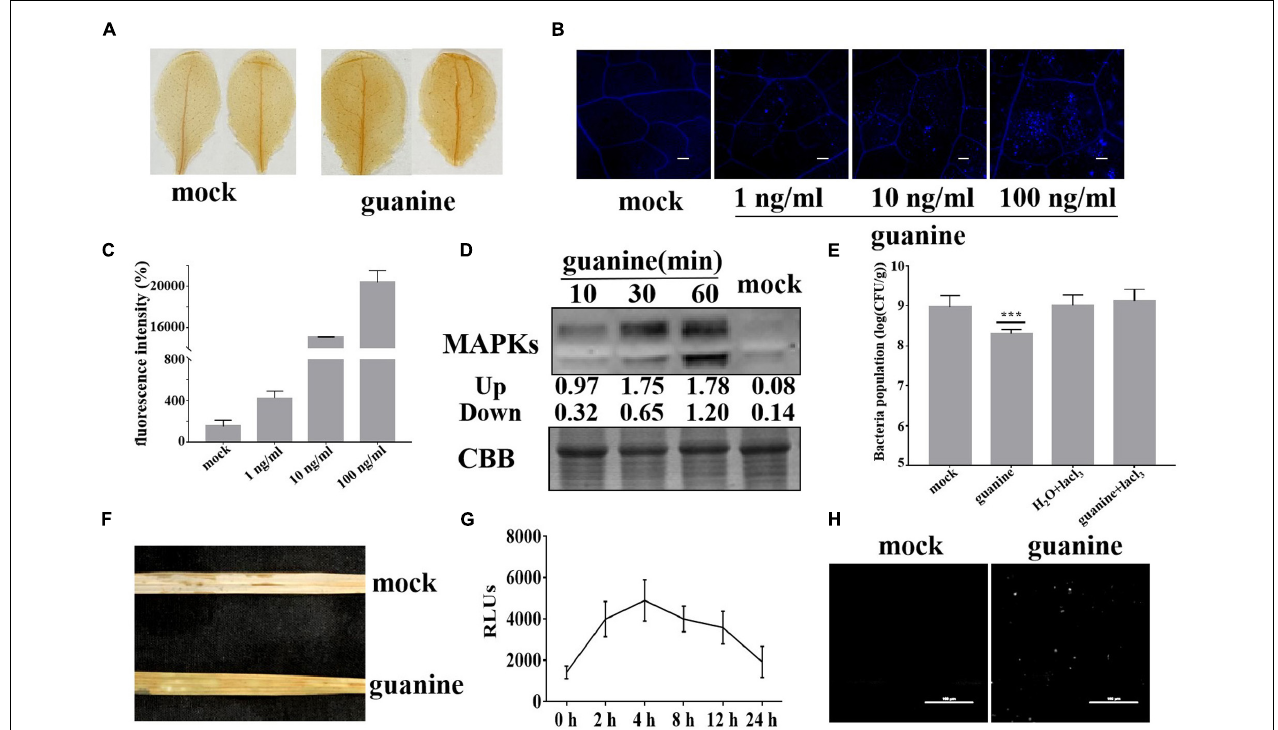
FIGURE 2 | Guanine-induced plant immune responses. (A) DAB staining to detect H 2 O 2 accumulation at 2 hpt after guanine treatment in Arabidopsis ; brown deposits indicate H 2 O 2 concentration. (B) Guanine-induced callose deposits in Arabidopsis . The leaves of 4-week-old Col-0 seedlings were treated with the mock and 1, 10, and 100 ng/mL guanine, and callose deposits were revealed by aniline blue staining. Scale bars = 25 µ m. (C) Quantification of callose fluorescence intensity of guanine-treated Arabidopsis leaves was performed using ImageJ software. Error bars indicate the SD ( n = 4). (D) Guanine-activated MAPK phosphorylation in Arabidopsis leaves. MAPK phosphorylation was detected by the phospho-p44/42 MPK antibody at the indicated times. Coomassie brilliant blue (CBB) staining of ribulose-1,5-bis-phosphate carboxylase/oxygenase was used to ensure equal protein loading in each lane. (E) Growth population of Pst DC3000 in the leaves of Arabidopsis plants treated with mock, guanine, H 2 O + lacl 3 or guanine + lacl 3 . Error bars indicate the SD. Asterisks indicate P < 0.001 (***) in Student’s t -test analysis. (F) Accumulation of H 2 O 2 in rice leaves after guanine treatment by DAB staining. (G) H 2 DCFDA was used to detect ROS accumulation in the rice leaves after guanine treatment at 0, 2, 4, 8, 12 and 24 h. Error bars indicate the SD ( n = 5). (H) Callose deposits in guanine-treated rice leaves after aniline blue staining. The leaves of 4-week-old ZH-11 seedlings were treated with mock and 100 ng/mL guanine and then stained using aniline blue. Scale bars = 100 µ m.